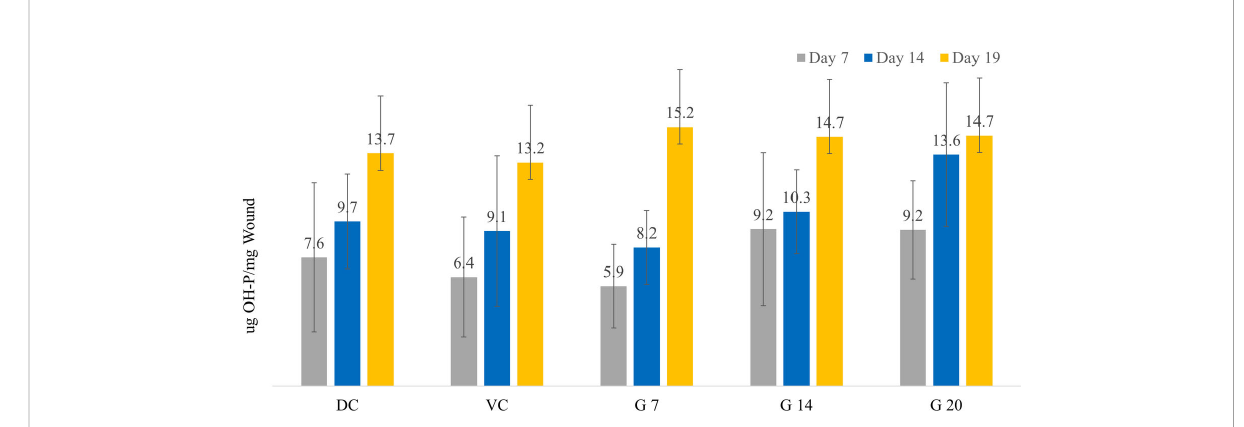
FIGURE 4 Shown are the hydroxyproline levels ( m g/mg wound tissue) across different treatment groups on days 7, 14, and